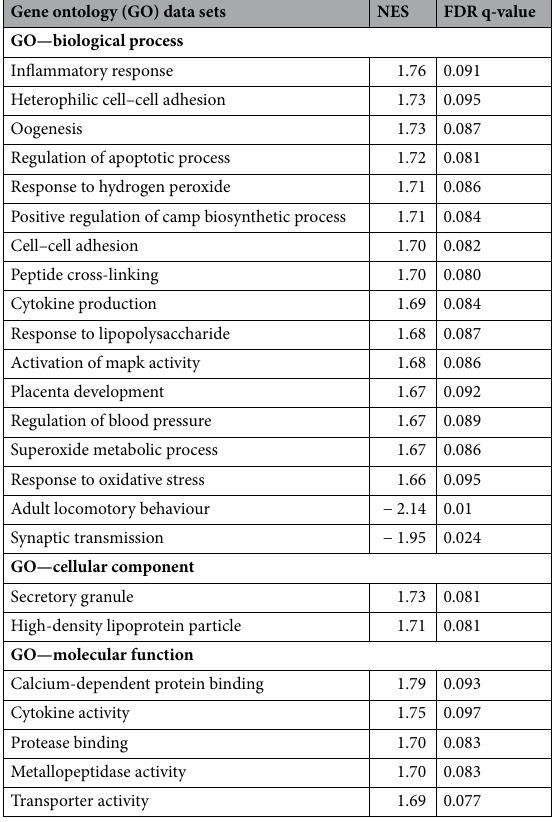
Table 1. Gene set enrichment analysis (GSEA) with gene ontology (GO) data sets. FDR False-discovery rate, NES Normalized enrichment